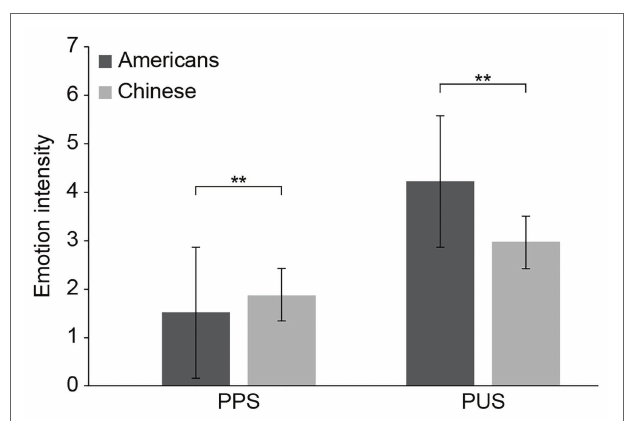
η 2 = 0.027, and culture and situation had significant interactions with discomfort, F (1, 313) = 63.996, p < 0.001, η 2 = 0.170. Results of simple effect analysis indicated that: in the PPS, Chinese participants significantly felt more discomfort than Americans, t (315) = 3.244, p < 0.01, d = 0.364; in the PUS, American participants significantly felt more discomfort than